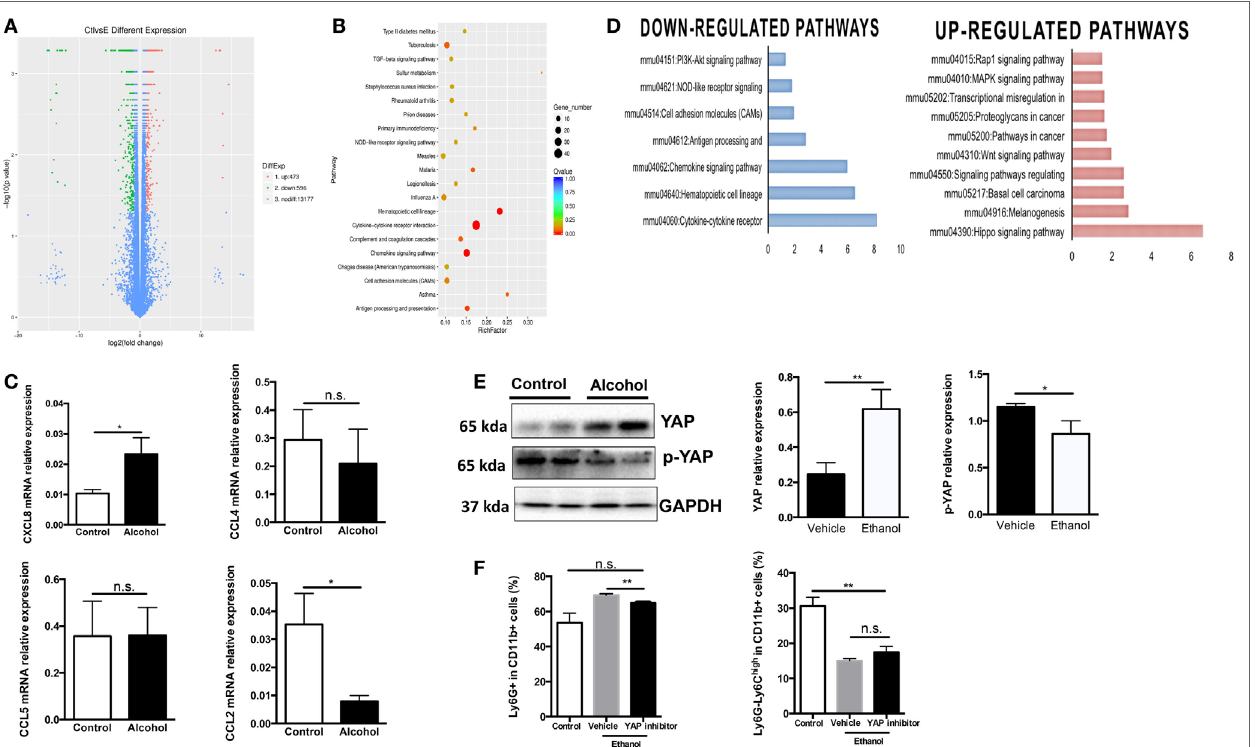
FigUre 5 | Molecular mechanism underlying ethanol-stimulated granulocytic-MDSCs (G-MDSCs) expansion and functioning. Bone marrow-derived cells treated with alcohol or vehicle for 5 h in vitro and subjected to transcriptomic analysis ( n = 3 for each group). (a) Volcano plot of differentially expressed genes in cells treated with PBS or ethanol. (B) Gene ontology analysis. (c) The mRNA level of several chemokine in sorted G-MDSCs cells treated with ethanol or vehicle in vitro determined by q-PCR. (D) Related downregulated pathways and upregulated pathways by ethanol treatment. (e) The protein expression level and phosphorylation level of YAP detected by western blotting in sorted G-MDSCs cells treated with ethanol or vehicle. Total protein was extracted from sorted G-MDSCs treated with vehicle or ethanol ( n = 4 for each group). (F) Presence of YAP inhibitor abrogates G-MDSCs expansion induced by ethanol. YAP inhibitor verteporfin was added into the culture medium at the final concentrations 2 µg/mL. The population of G-MDSCs was determined after culturing 5 h with ethanol. Data were analyzed as mean value ± SD and Student’s T -test was used to assess the result significance. * p < 0.05, ** p < 0.01, compared with the control group; n.s., not